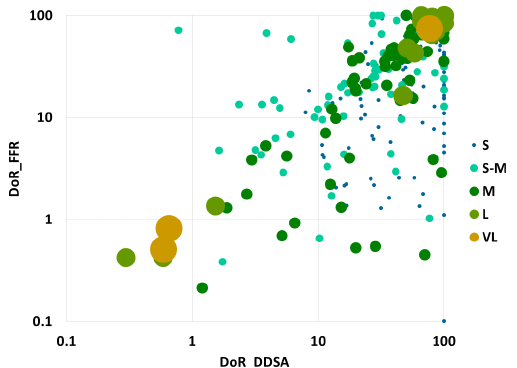
Figure 6. DoR sensitivity analysis. Degree-of-regulation values from the DDSA database (DoR_DDSA) were compared with matching values from the degree-of-regulation values (DoR_FFR) of Grill et al. (2019). River were classified by their average mean flow; smaller dots represent small rivers, and bigger dots repre- sent large to very large rivers. S: small; S–M: small to medium; M: medium; L: large; VL: very